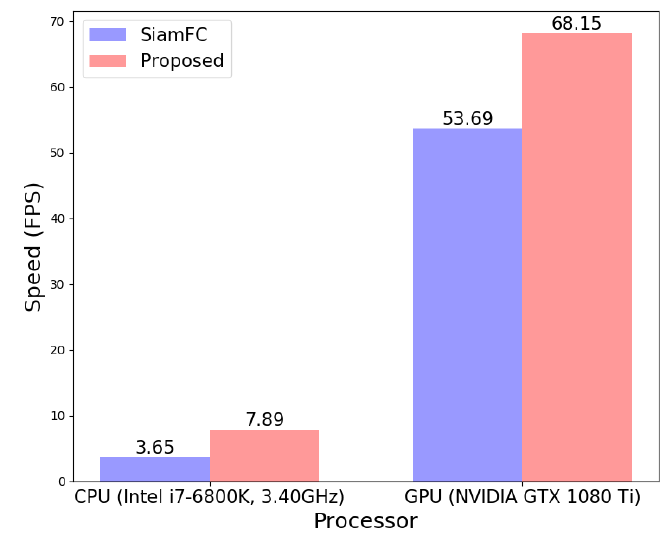
Figure 4. The tracking speed from CPU and GPU.